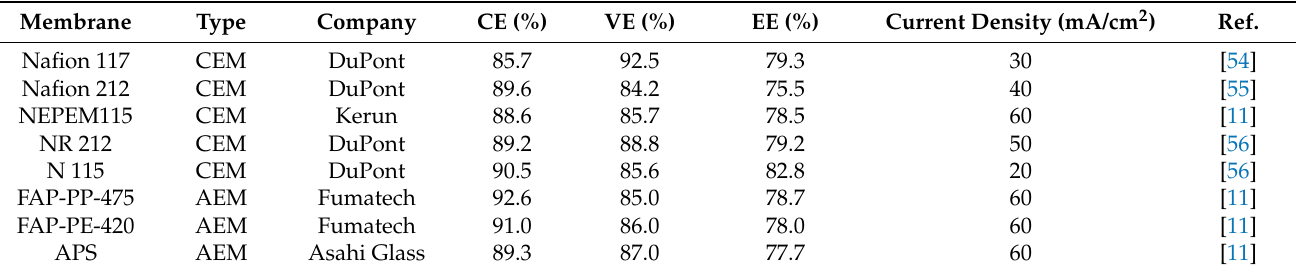
Table 7. VRFB performances of various commercial CEMs and AEMs.